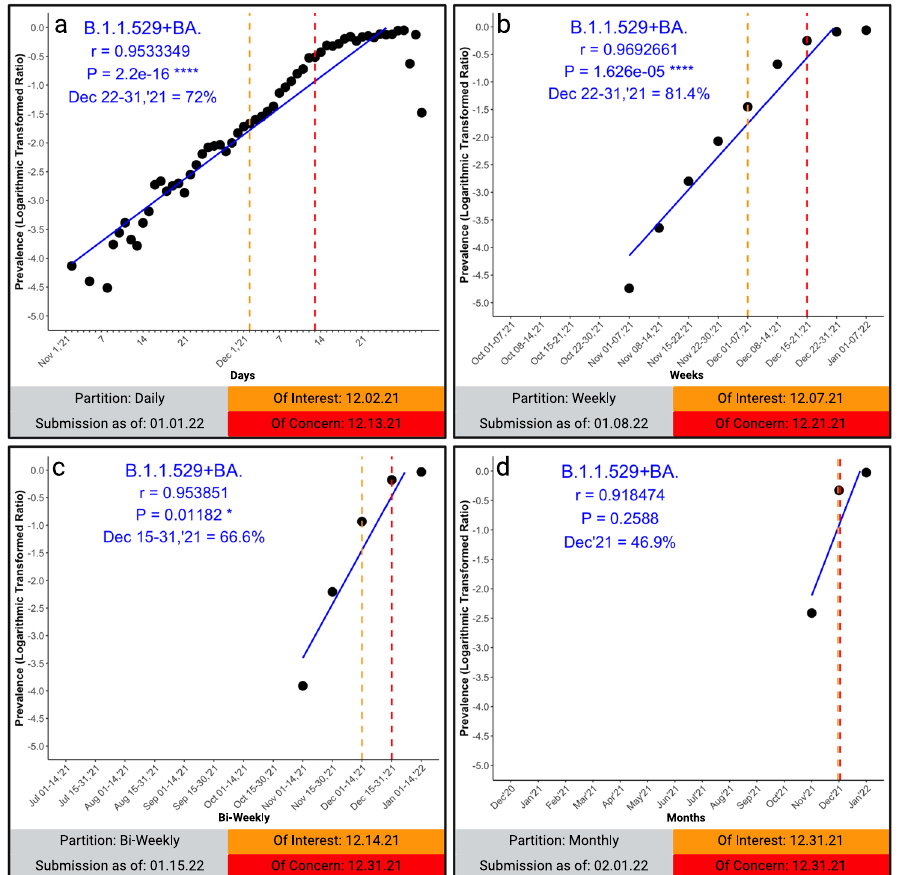
Fig. 3 Pearson ’ s correlation on logarithmically-transformed prevalence ratios of the omicron SARS-CoV-2 variant of concern. This fi gure demonstrates the quantitation of the Omicron SARS-CoV-2 variant of concern. The emergence is shown for the collective variant (B.1.1.529 + BA.*). The partitions are demonstrated in daily partitions ( a ) ( n = 1,077,671 biologically independent samples), weekly partitions ( b ) ( n = 1,375,929 biologically independent samples), bi-weekly partitions ( c ) ( n = 1,582,268 biologically independent samples), and the prototype monthly partition ( d ) ( n = 2,154,954 biologically independent samples). Each lineage and partition displays the date the VOC would be classi fi ed “ of interest ” (orange/orange dashed-lines) and “ of concern ” (red/red dashed-lines) as de fi ned by the Algorithm. Additionally, the cut-off date for submissions demonstrates when the classi fi cation would occur. * p < 0.05, ** p < 0.005, *** p < 0.0005, **** p < 0.00005. Graphs were generated using open-source R and the ggplot2 package under MIT +